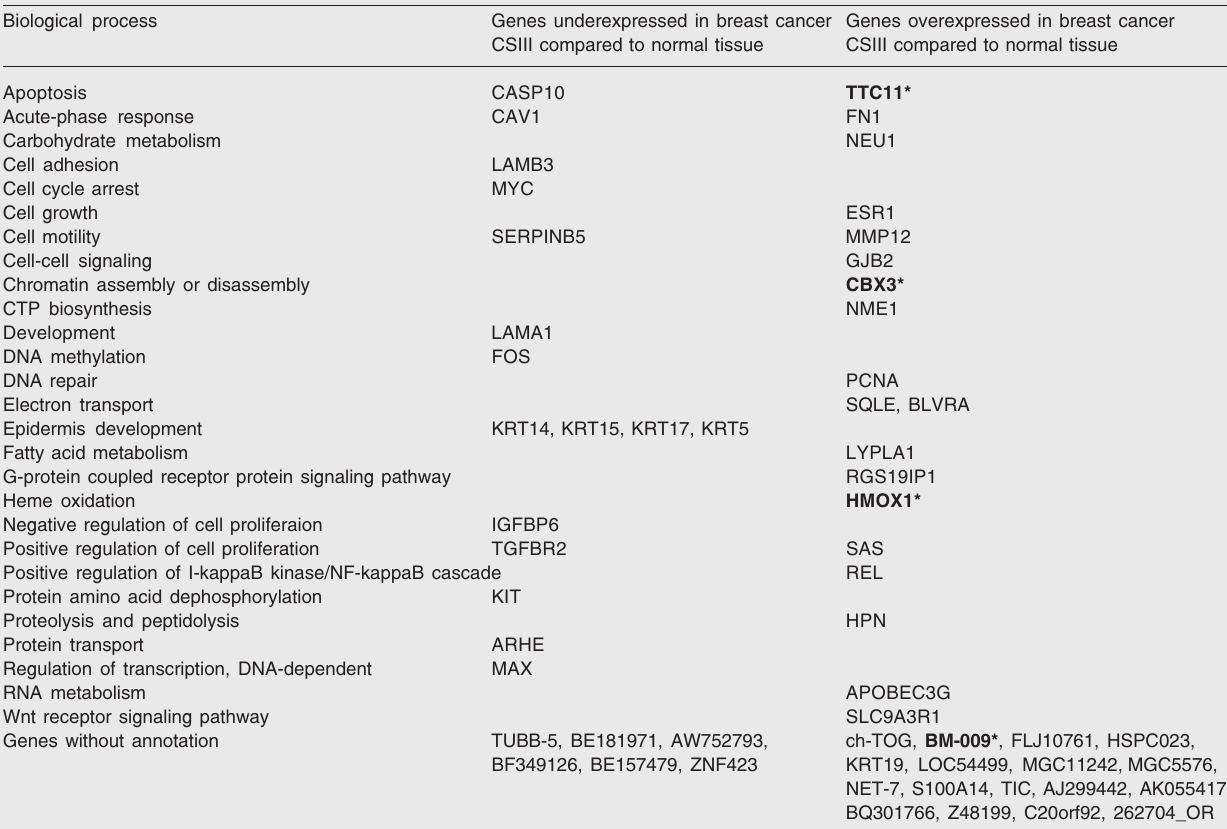
Table 4. Genes differentially expressed in clinical stage III (CSIII) tumors and in normal tissue according to their Gene Ontology annotation (biological